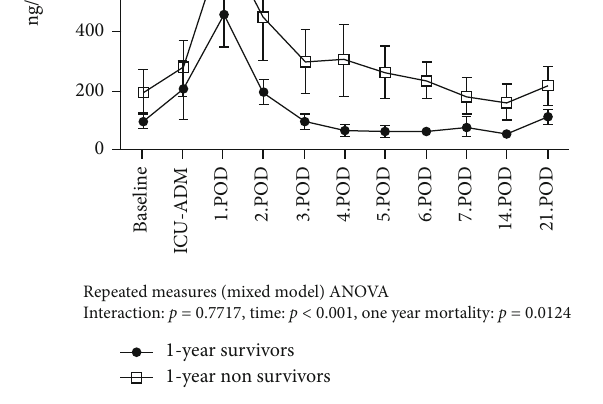
Figure 3: Temporal pattern of sST2 levels in 1-year survivors and 1- year nonsurvivors. Given are the results of mixed model analysis ANOVA for repeated measures.